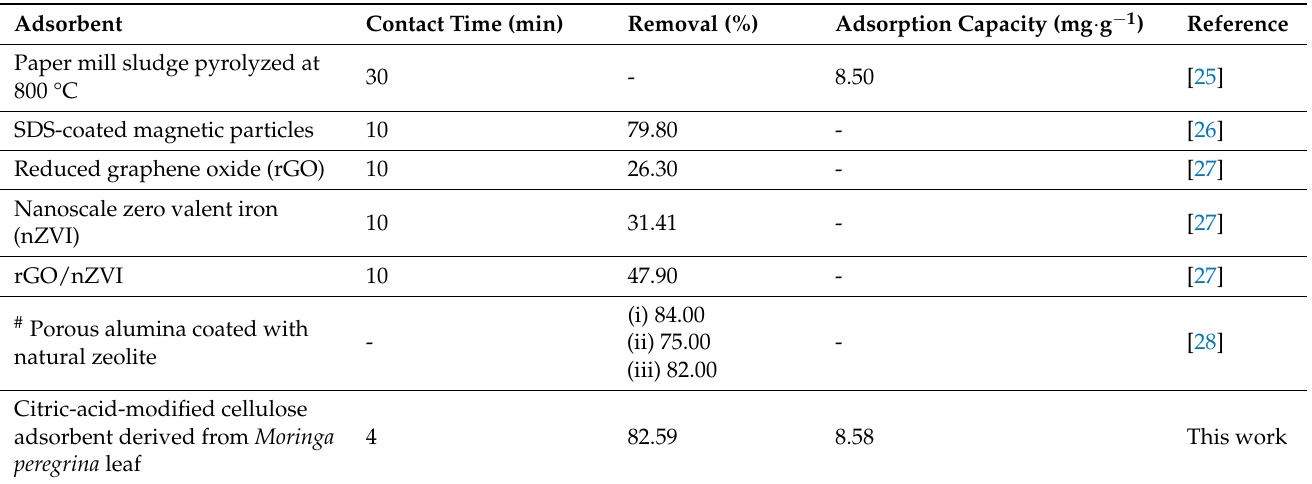
Table 5. Comparison of the performance of citric-acid-modified cellulose adsorbent derived from Moringa peregrina leaf with other adsorbents for the removal of